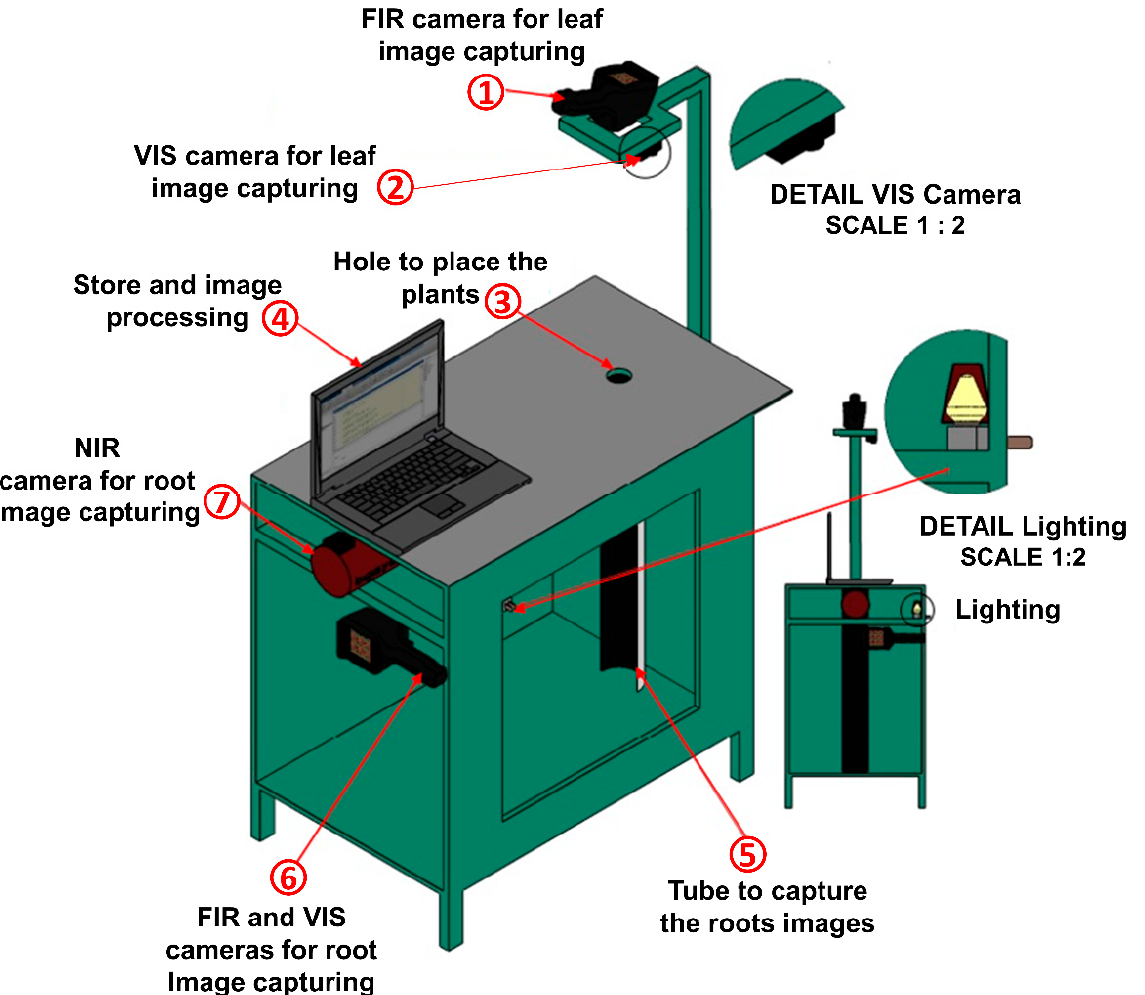
Figure 4. Model of the multispectral vision system.